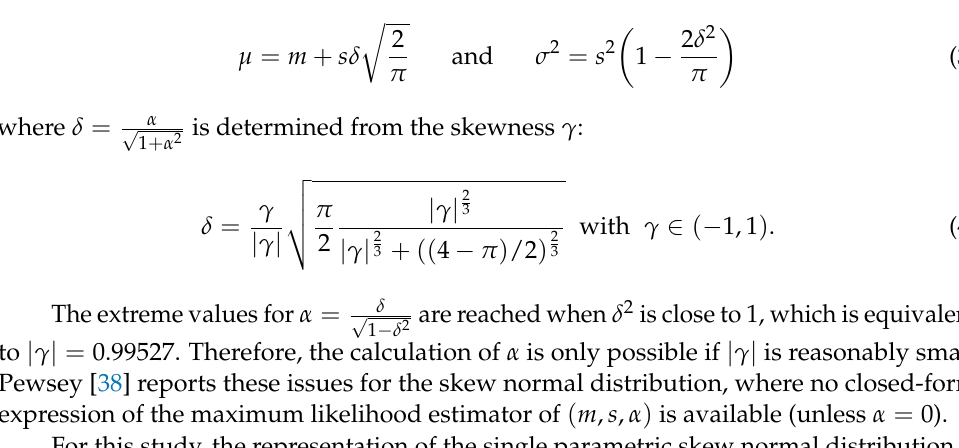
Figure 2. Standard skew normal densities ( m = 0 and s = 1) as a function of the parameter α . The skew normal distribution has a mean and variance, respectively,